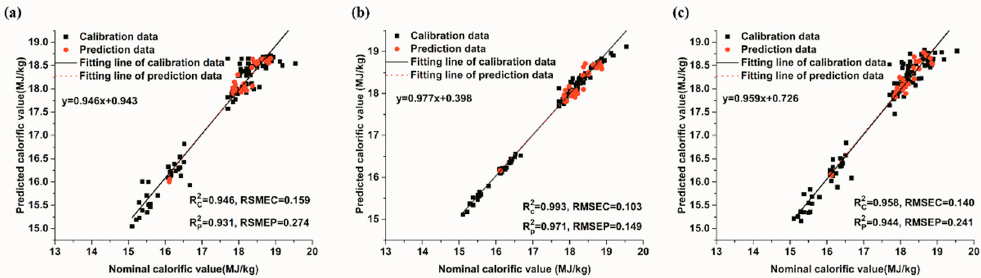
Figure 7. Model fitting results for CV. ( a ) PLSR (partial least-squares regression); ( b ) LS-SVM (the least-squares support vector machine); ( c ) ELM (extreme learning machine).